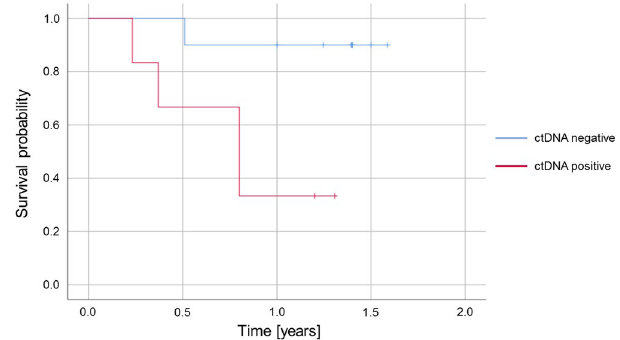
Figure 4. Kaplan-Meier plot representing the probability to relapse within 1 year for patients who underwent complete resection and who had mutations detectable in tissue-based analysis (n = 16). Compared are patients with and without detectable levels of circulating tumour DNA (ctDNA) at primary